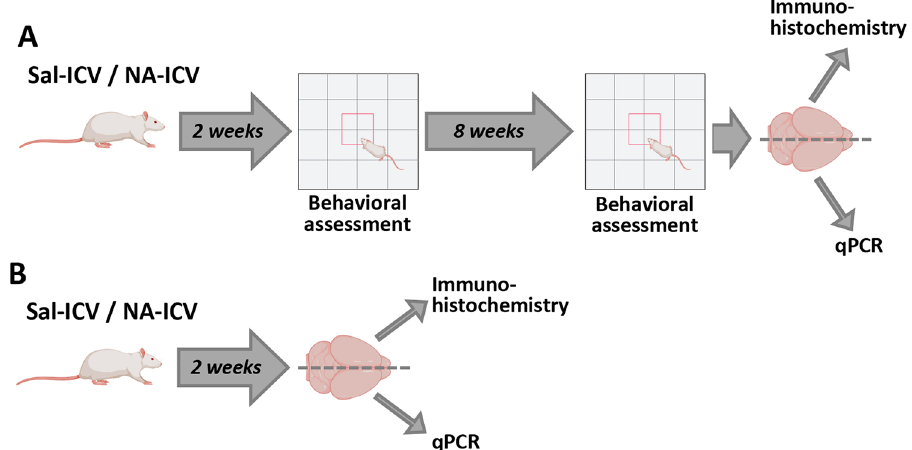
Figure 1. Schematic representation of the experimental design. ( A ) The rats were ICV-injected either with neuraminidase (NA) or with saline (Sal) as control. A behavioral assessment (consisting in open field test and a battery of neurological tests) was carried out 2 weeks after the ICV-injection, and later again at 10 weeks post- ICV. Then, the animals were sacrificed and their brains removed for the study of the inflammatory status by immunohistochemistry and qPCR. ( B ) Some animals were ICV-injected and sacrificed 2 weeks later, with the aim of obtaining brain tissue samples for studying the inflammatory situation at this time